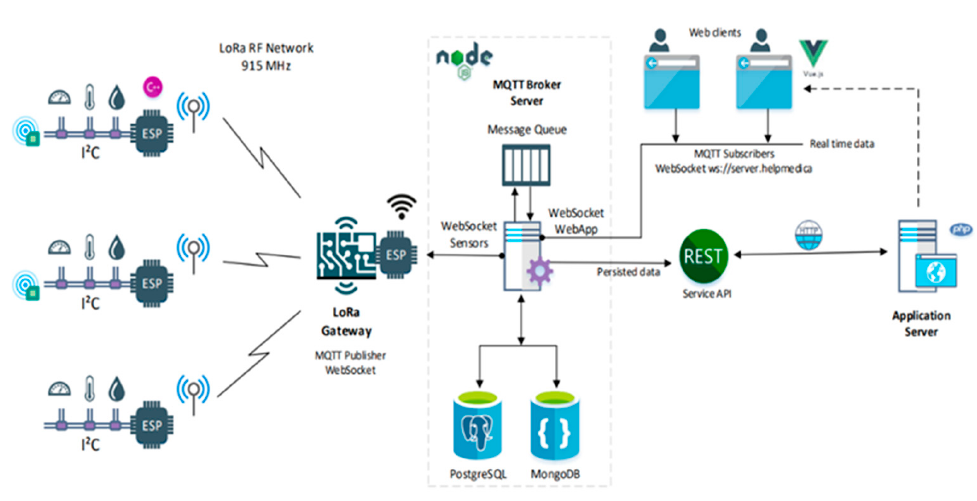
Figure 11. IoT Architecture on LoRa Network.